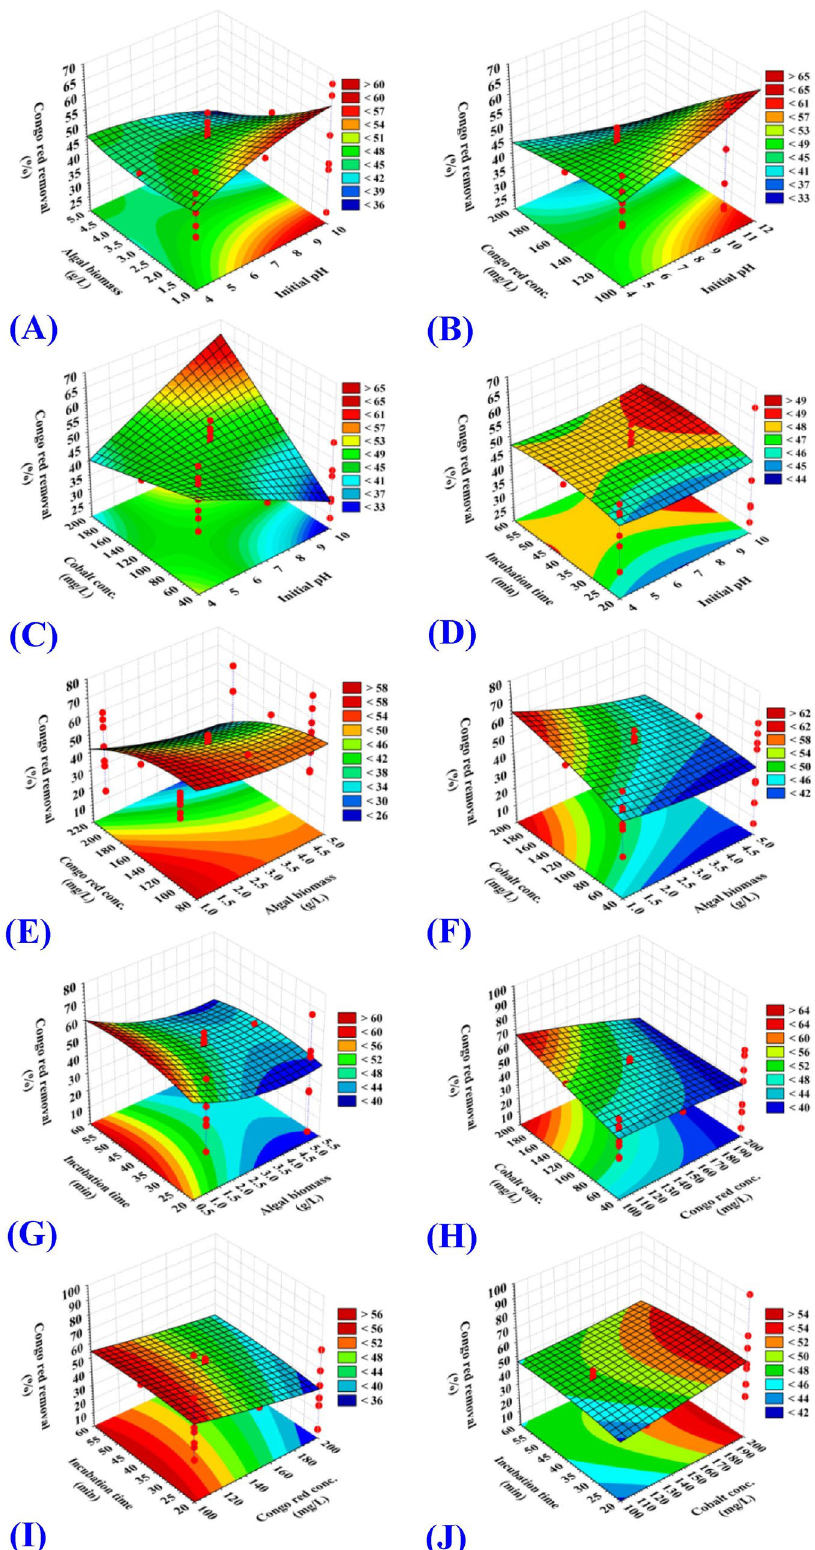
Figure 1. Three-dimensional surface plot for biosorption of Congo red by E. intestinalis showing the interactive effects of two variables at a time of the five tested variables. ( A ) initial pH level and algal biomass concentration, ( B ) initial pH level and Congo red concentration, ( C ) initial pH level and cobalt concentration, ( D ) initial pH level and incubation time, ( E ) algal biomass conc. and Congo red concentrations, ( F ) algal biomass and cobalt concentrations, ( G ) algal biomass concentration and incubation time, ( H ) Congo red and cobalt concentrations, ( I ) Congo red concentration and incubation time and ( J ) cobalt concentration and incubation